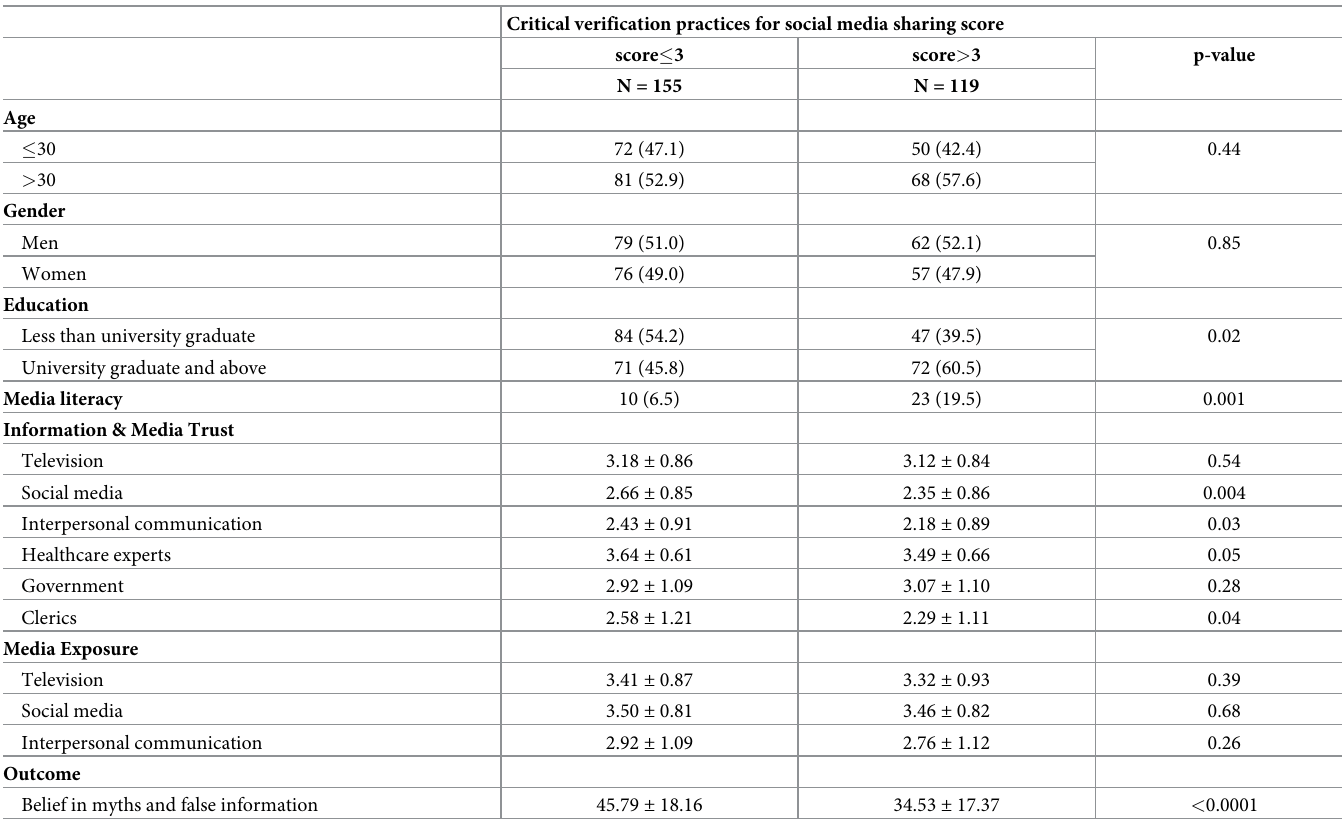
Table 3. Association of trust in media/information sources and belief myths/false information with critical verification practices for social media sharing.